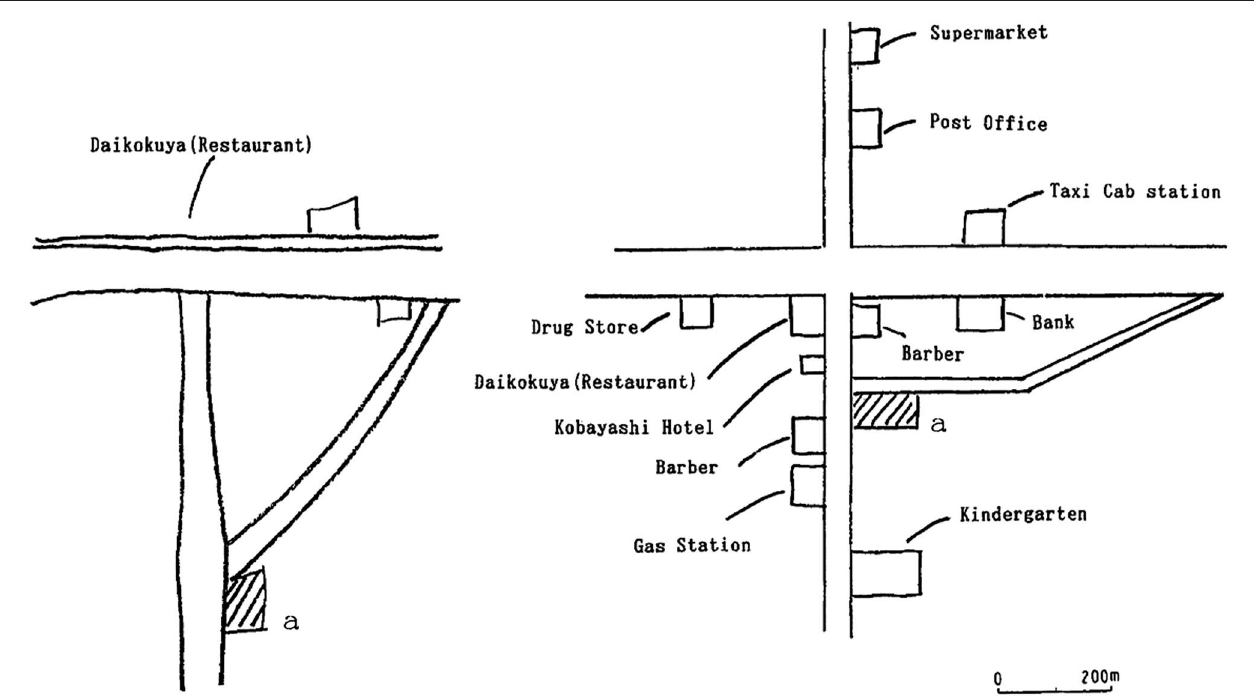
locations of buildings in his neighborhood, despite being able to recall their names (left drawing). His wife’s drawing is shown on the right for comparison. Adapted from Takahashi et al.